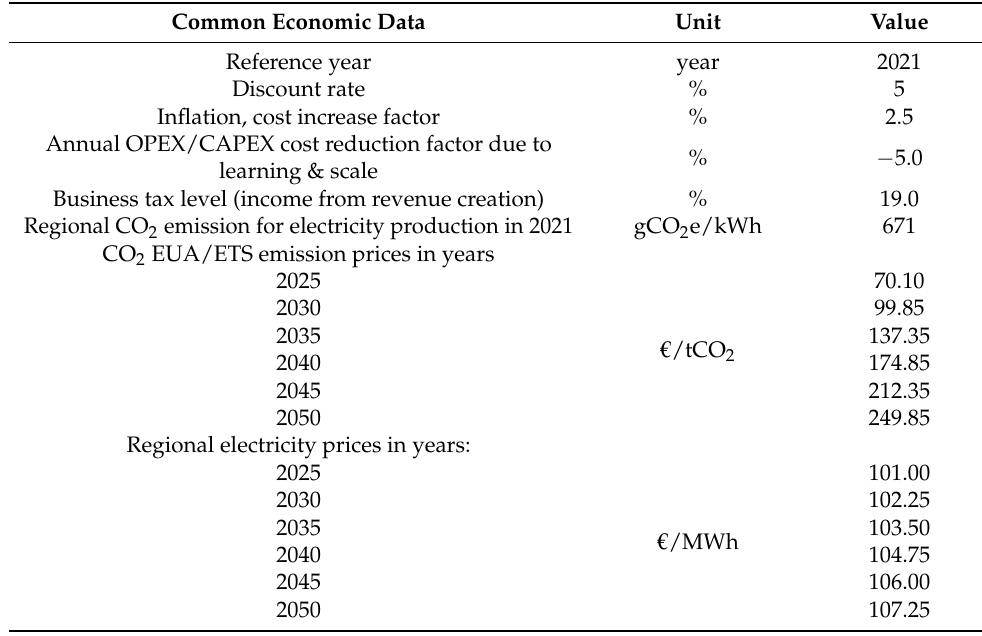
Table 6. Common economic data and regional sites specific